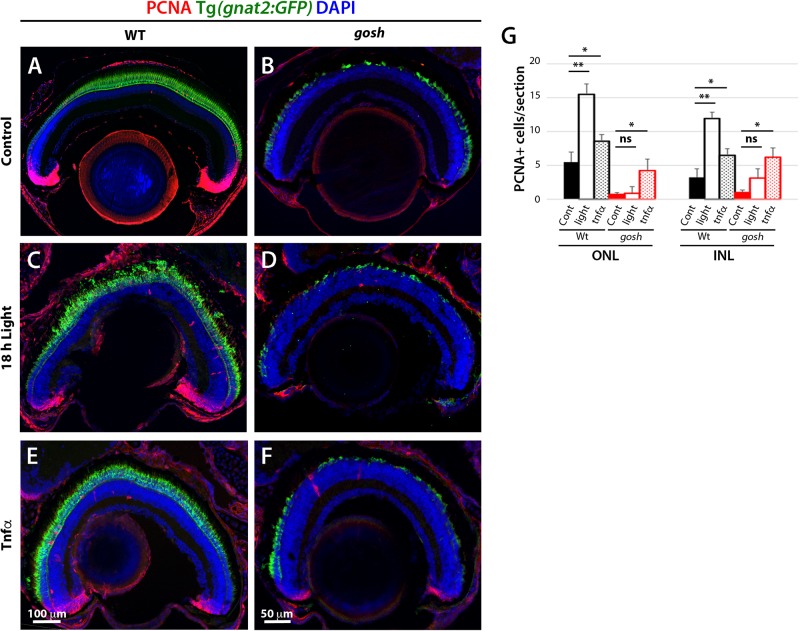
Proliferation of Müller glia and rod precursor cells is not activated by light-induced damage, but by TNFα in gosh mutants at 3 wpf. Wild-type and gosh mutant retinas at 3 wpf are labeled with anti-PCNA antibody. Nuclei are stained with DAPI. The transgene Tg(gnat2:GFP) visualizes cone photoreceptors. In wild-type, undamaged controls, PCNA is expressed in the CMZ, and PCNA-positive cells are observed in the INL and ONL (A). However, the PCNA signal is almost absent in gosh mutant retinas (B). Treatment for 18 h under intense light damages photoreceptors (C,D). Wild-type sibling retinas showed an increase in the number of PCNA-positive cells located in the INL and ONL. On the other hand, the PCNA signal is still absent in gosh mutant retinas. TNFα intravitreal injections increase the number of PCNA-positive cells in wild-type sibling and gosh mutant retinas (E,F). Histogram depicting the number of PCNA-positive cells (G). Bars and lines indicate mean ± SEM, n: 6–11. Black and red bars, wild-type siblings and gosh mutants. Filled bars, no treatment; Open bars, photodamaged samples; Dotted bars, TNFα-injected sample (ns, p > 0.05; ∗p < 0.05; ∗∗p < 0.01).